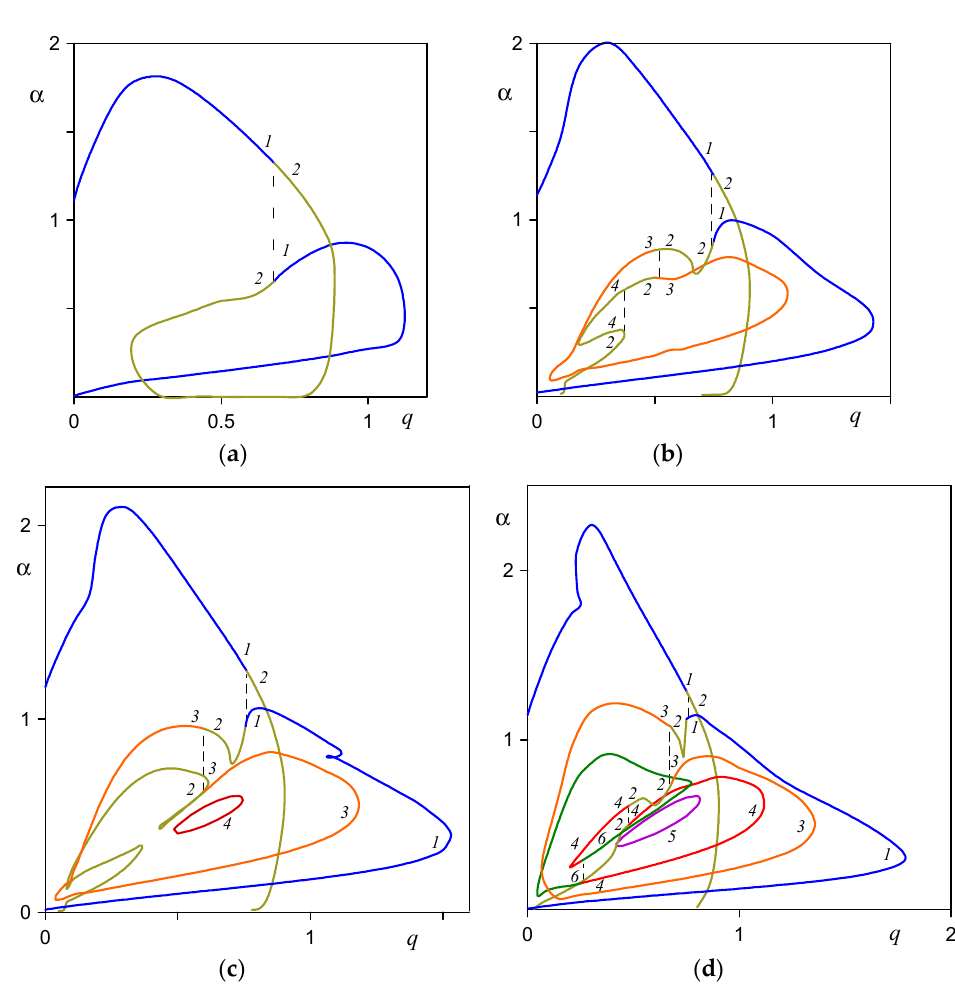
Figure 3. The lines depict the constant growth rate of the values const =α=ω ii с in plane ),( q α at Re = 60: ( a ) mode 1; ( b ) mode 2. The outer contour corresponds to the neutral curve on which 0 =ω i . The flows are unstable inside it, and one is stable outside it.